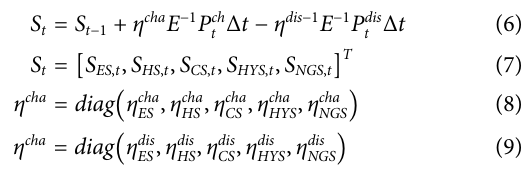
Frontiers in Energy Research |